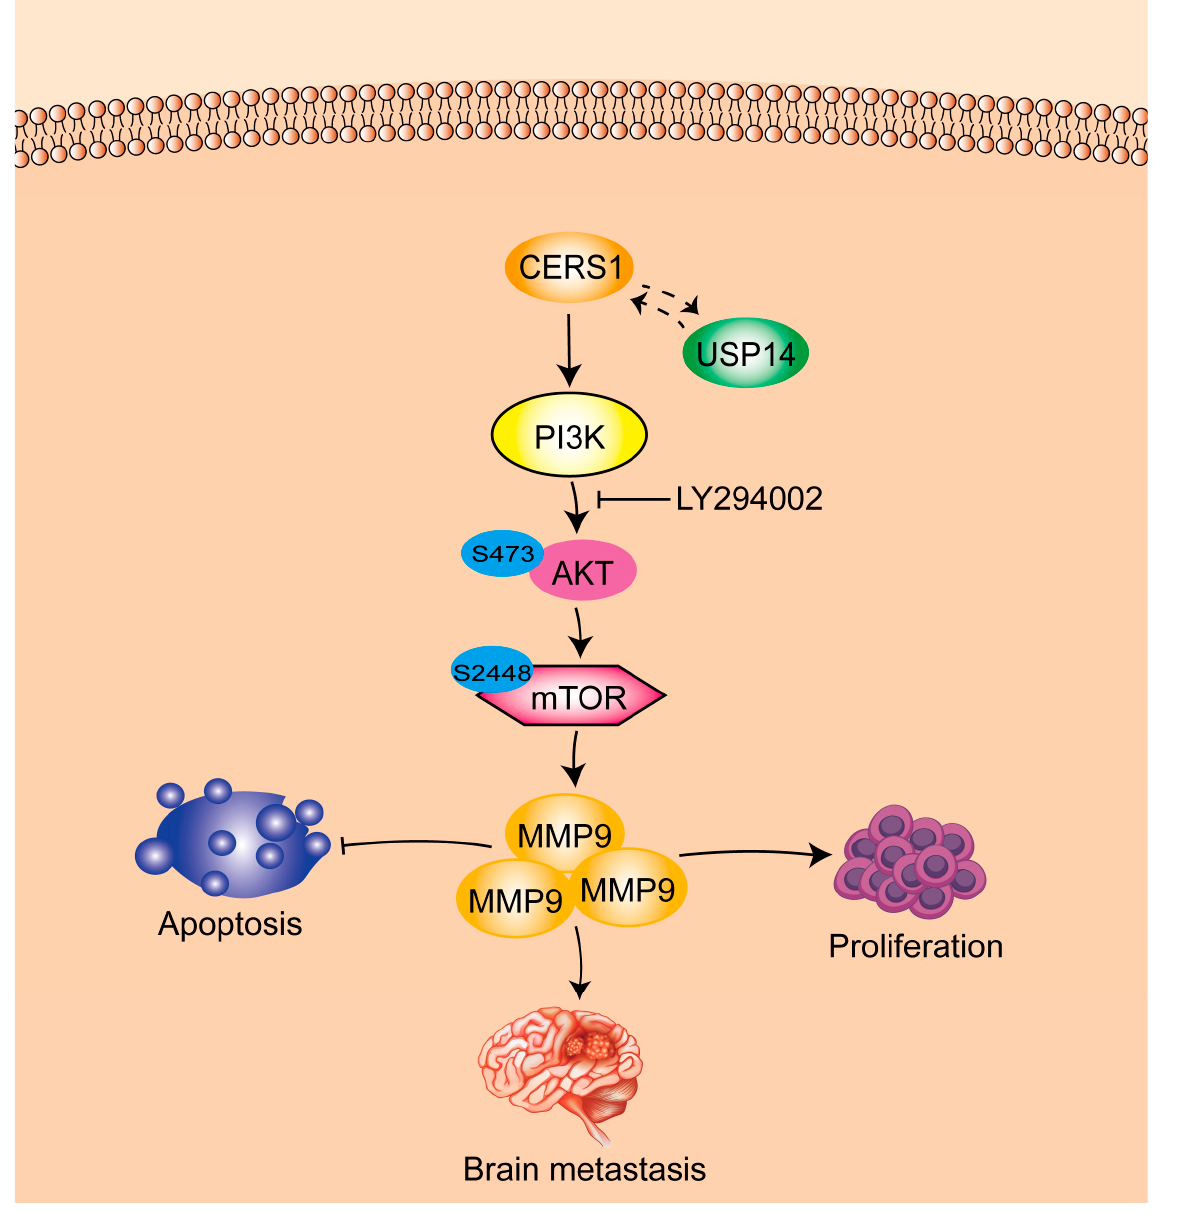
Figure 6. Schematic diagram showing the molecular mechanism of CERS1 in NSCLC BM.